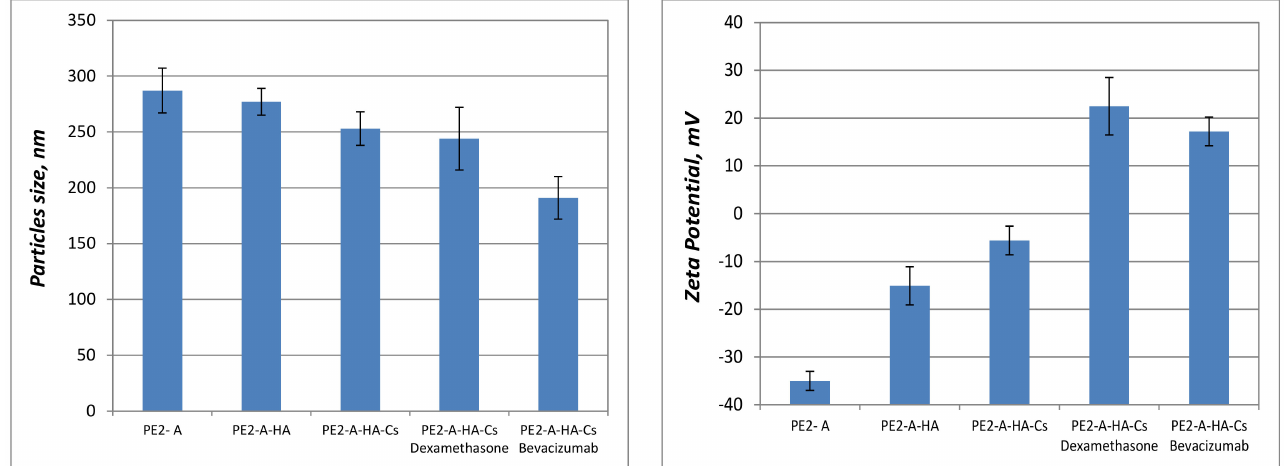
Figure 3. Size (nm) and zeta potential (mV) for pre-emulsion prepared with vitamin A (PE2-A), particles coated with sodium hialuronate (PE2-A-HA), particles coated with sodium hialuronate and chitosan (PE2-A-HA-Cs) and particles coated with biopolymers and dexamethasone/bevacizumab